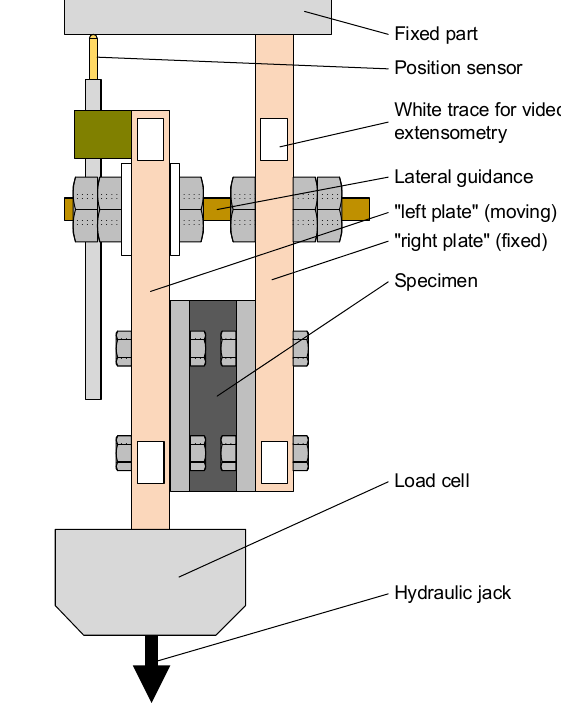
Fig. 10 Schematic sketch of the test